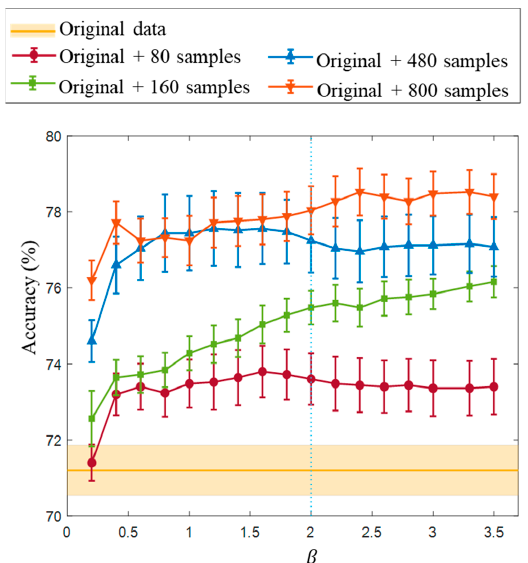
Figure 9. Classification accuracy when GNDv1 is used; the symbols and error bars represent the average accuracy and standard error, respectively.